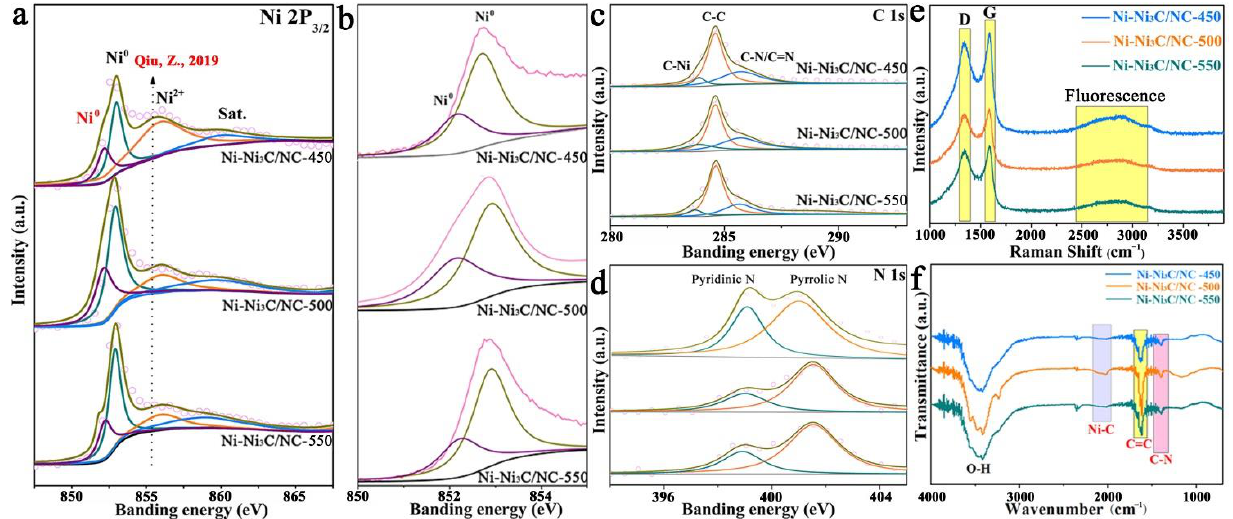
Figure 2. Chemical state characterizations of the as-obtained samples. ( a – d ) XPS spectra of Ni- Ni 3 C/NC prepared at 450, 500, and 550 °C. ( a ) Ni 2p spectra, ( b ) enlarged Ni 0 2p spectra. ( c ) C 1s Ni 3 C/NC prepared at 450, 500, and 550 ◦ C. ( a ) Ni 2p spectra, ( b ) enlarged Ni 0 2p spectra. ( c ) C 1s spectra. ( d ) N 1s spectra. ( e , f ) Raman and FT-IR spectra of the samples. spectra. ( d ) N 1s spectra. ( e , f ) Raman and FT-IR spectra of the